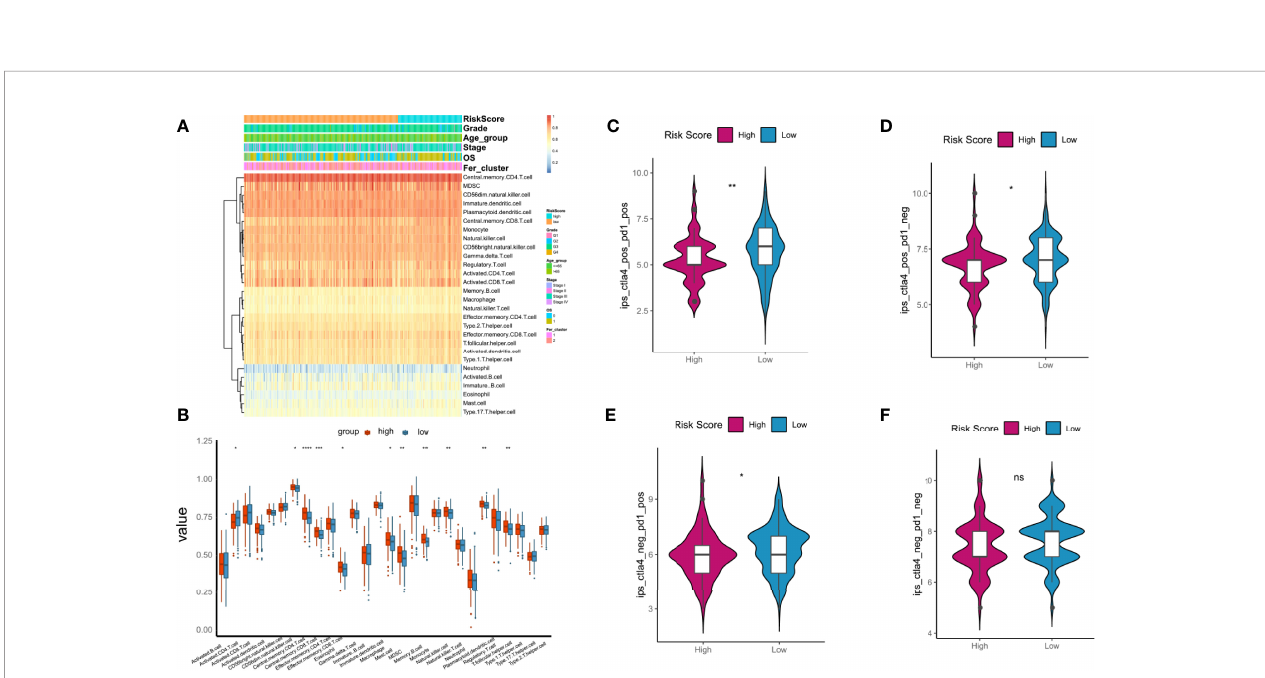
FIGURE 11 | Relationships between tumor risk score and immune cell in fi ltration (ICI). (A) Heatmap of distribution of ICI ratios; (B) boxplot of differences in ICI between high- and low-risk score groups; (C – F) relationships between tumor risk score and related immunophenoscore. P < 0.05 was considered as signi fi cant. ns, no signi fi cance. *P < 0.05, **P < 0.01, ***P < 0.001, ****P < 0.0001.